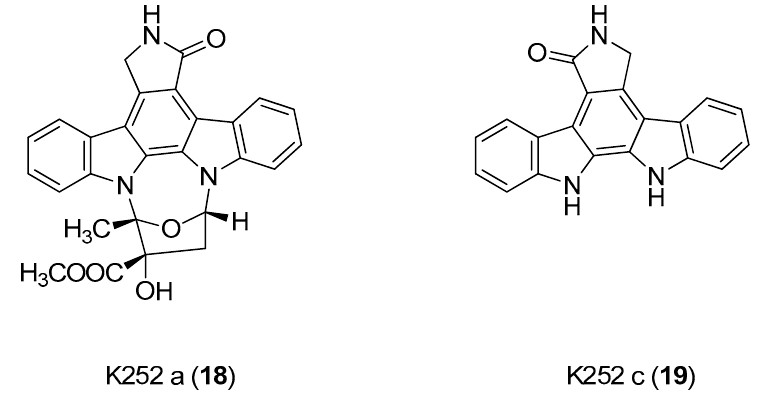
Figure 7. Structures of indolocarbazoles K252a ( 18 ) and K252c ( 19 ).